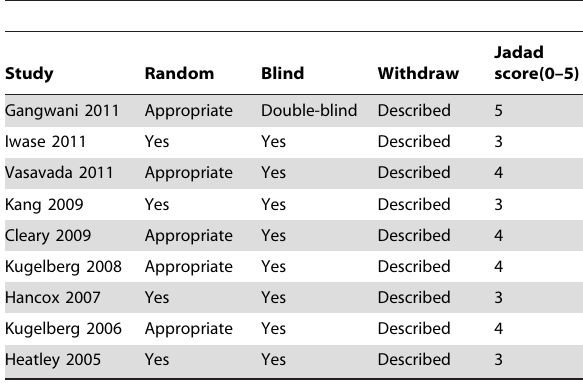
Table 1. Evaluation of the quality of RCTs included in the